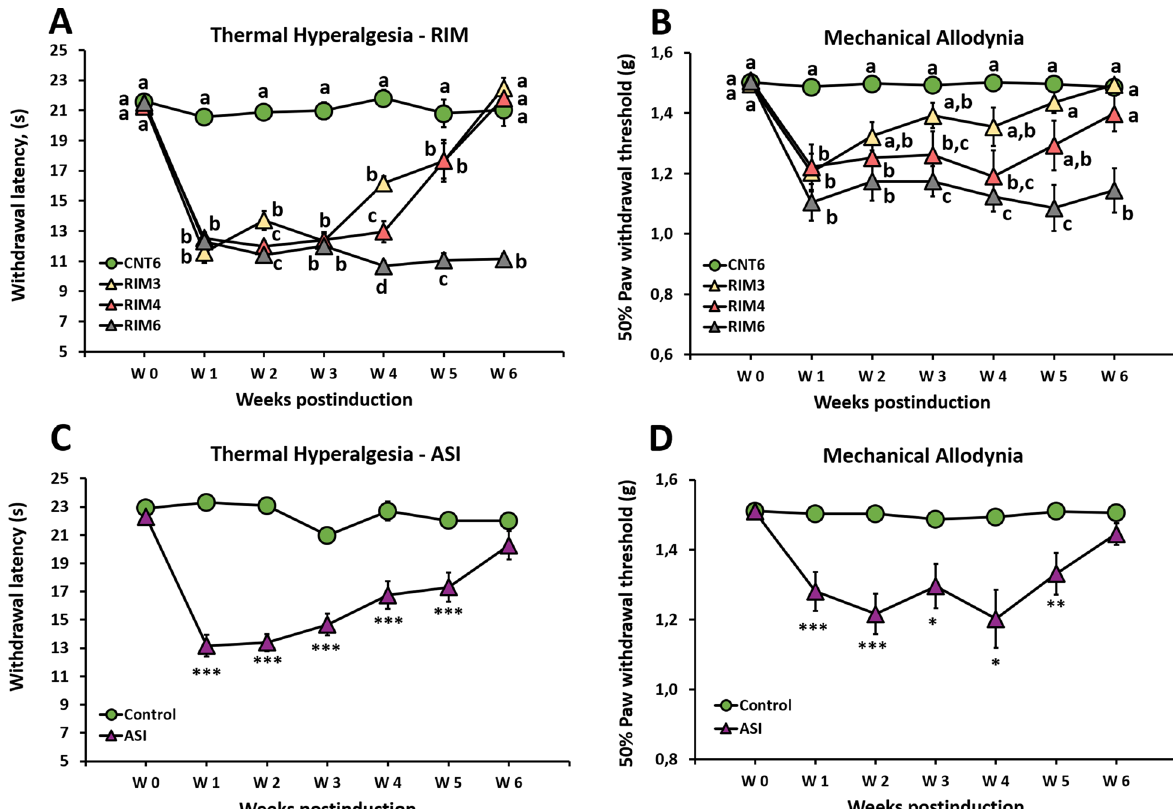
Figure 1. Time course of reflexive pain responses in mice subjected to reserpine-induced myalgia and intramuscular acid saline solution injection. The RIM6 mouse model shows longer-lasting reflexive pain responses than either RIM3 or RIM4 since only RIM6 animals showed significant thermal hyperalgesia ( A ) and mechanical hypersensitivity ( B ) up to 6 weeks postinduction. The ASI mouse model shows long-lasting thermal hyperalgesia ( C ) and mechanical hypersensitivity ( D ) up to 5 weeks postinduction. Each point and vertical line represent the mean ± standard error of the mean (n = 9–12 per group). a–d: Groups not sharing a letter are significantly different, p < 0.05 according to post hoc test; *** p < 0.0001, ** p < 0.01, * p < 0.05 significant decrease versus ASI-Control, by post hoc